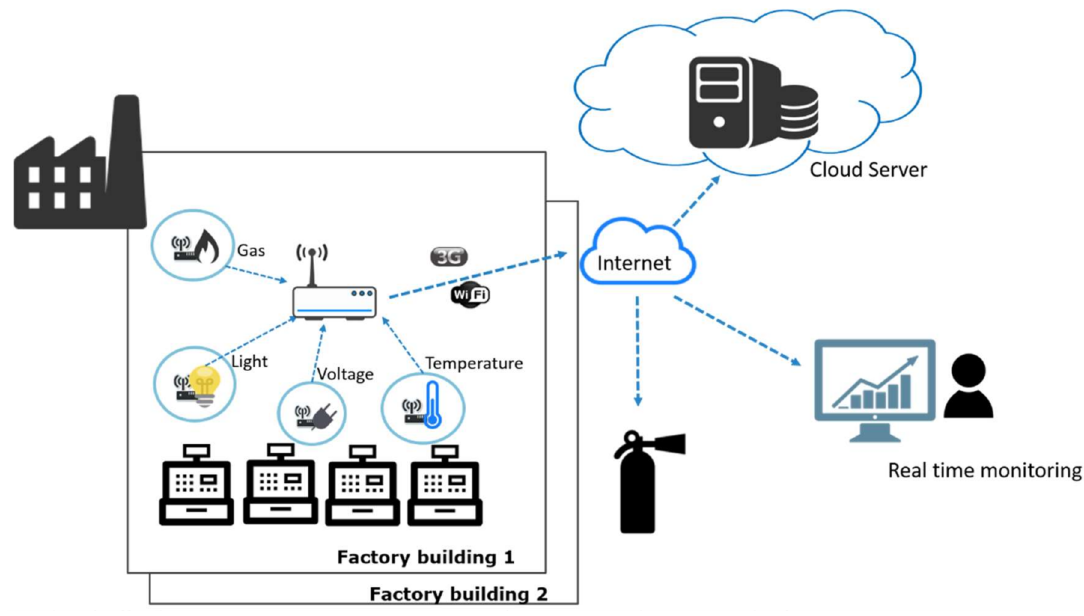
Figure 3. The possible IoT architecture for factory monitoring